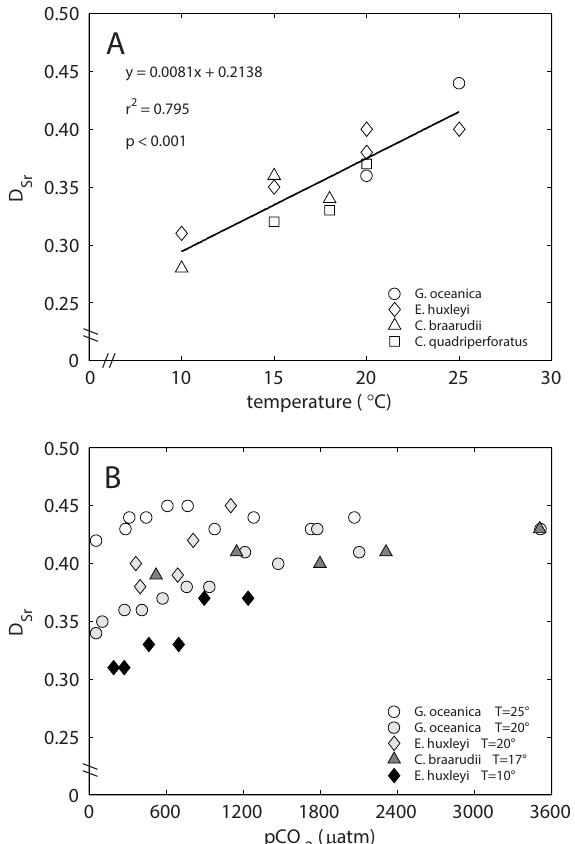
Fig. 1. Strontium partition coefficient ( D Sr ) as a function of (A) temperature ( p CO 2 = 370 ± 70µatm) and (B) p CO 2 (temper- ature as indicated). Black line in (A) represents a linear regression through all data points. Please note that G. oceanica experienced nutrient limitation at 25 ◦ C (see text for details).